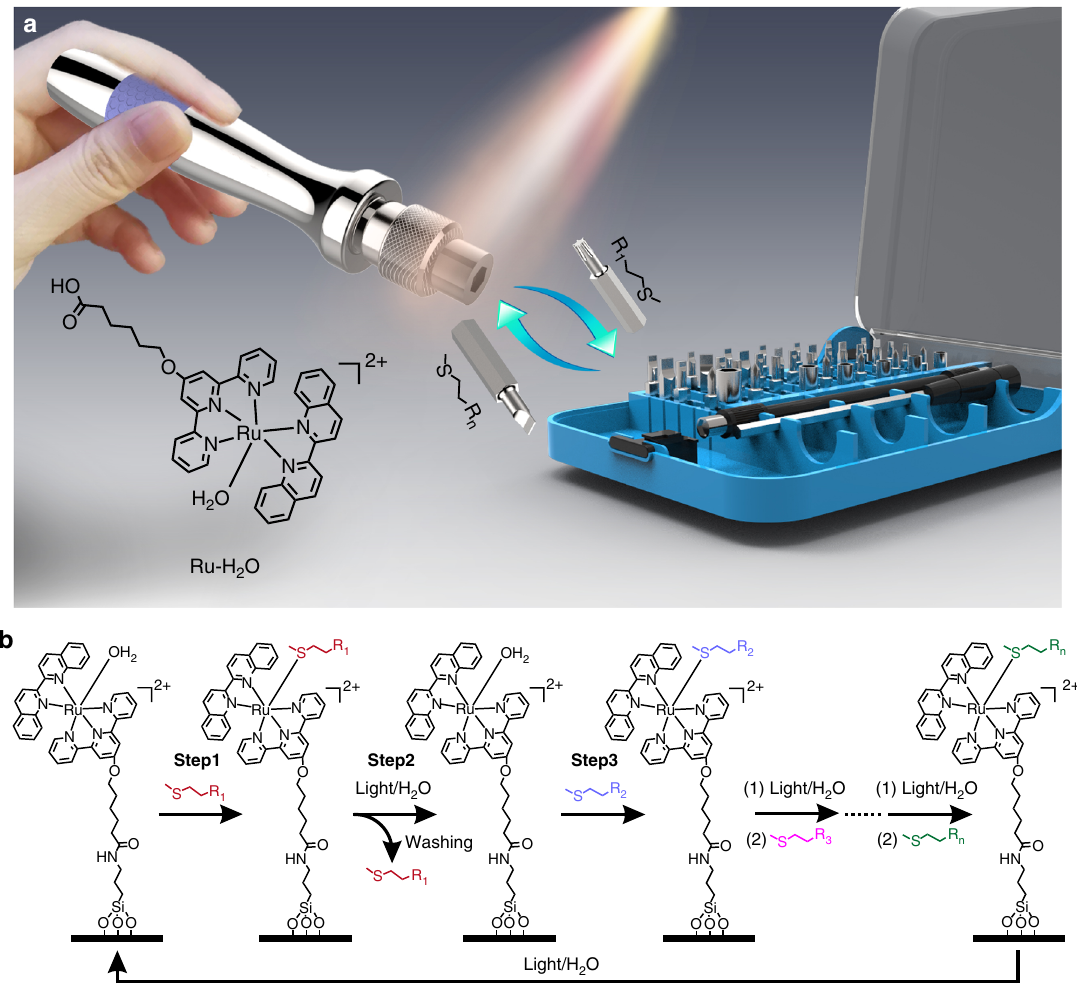
Fig. 1 Concept and mechanism of recon fi guring surface functions using visible light. a Schematic diagram of the visible-light-controlled recon fi gurable multi-functional platform. Ru-H 2 O acts as a screwdriver, which can take a functional bit (thioethers with different functional groups) and change the function via ligand substitution. b The mechanism of recon fi guring surfaces via ligand substitution. A thioether ligand substitutes the coordinated H 2 O molecule in the dark and a H 2 O molecule substitutes a thioether ligand under visible-light irradiation. This process can occur for many times to recon fi gure the